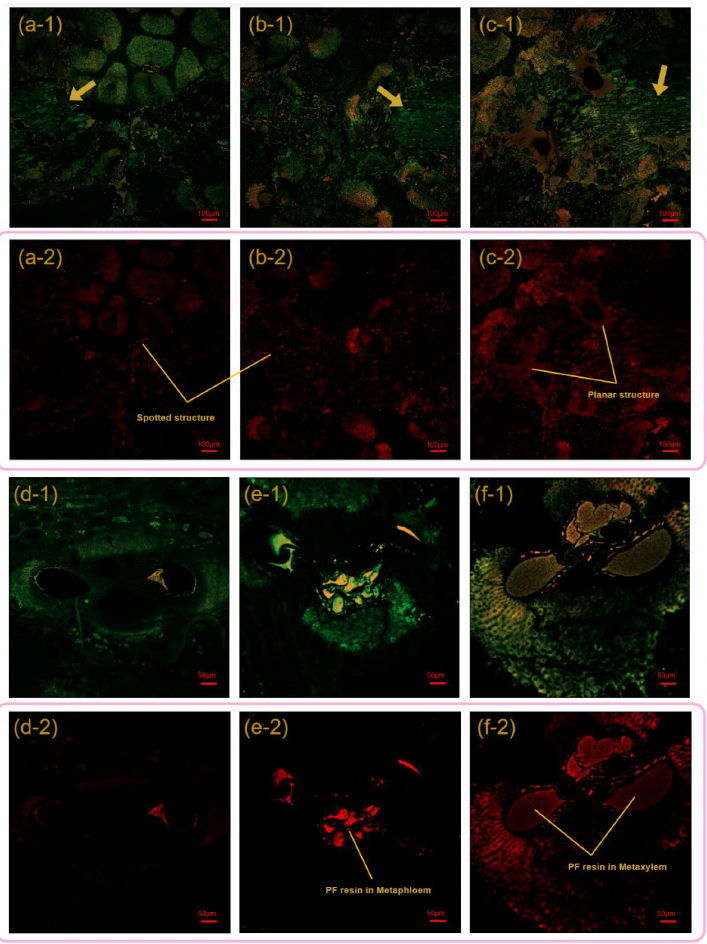
Figure 4. The LSM images of the macroscopic bonding interface and the cured PF resin trapped in the bamboo vascular tissue: ( a , d ) BSC-10-1.15, ( b , e ) BSC-15-1.15, ( c , f ) BSC-20-1.15. Note: 1 and 2 denote dual-channel superposition diagrams and single-channel diagrams,